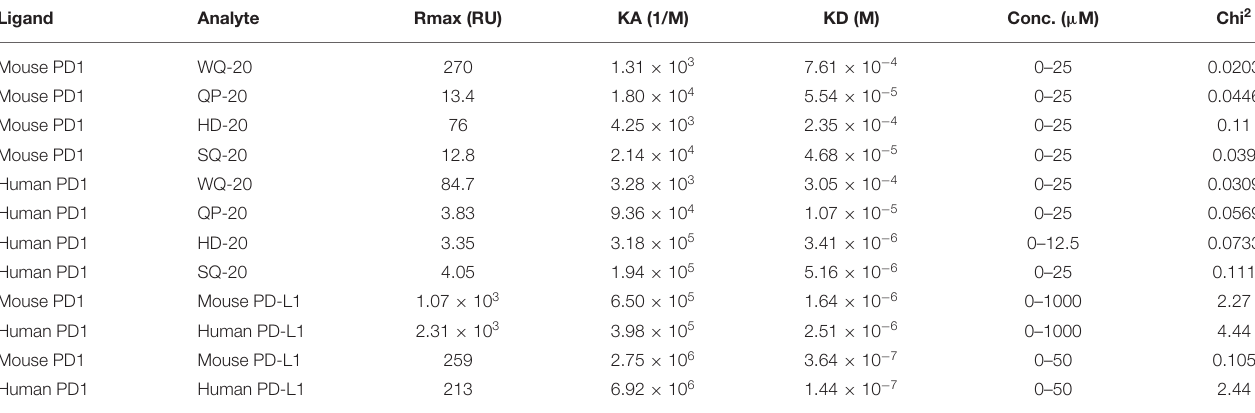
TABLE 2 | Binding of peptides to human and mouse PD1